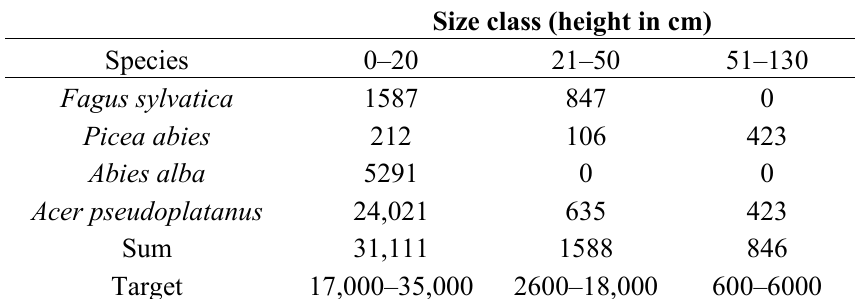
Table 2. Number of seedlings in size classes by species ha − 1 . Target values were estimated from Duc [20] and Bachofen